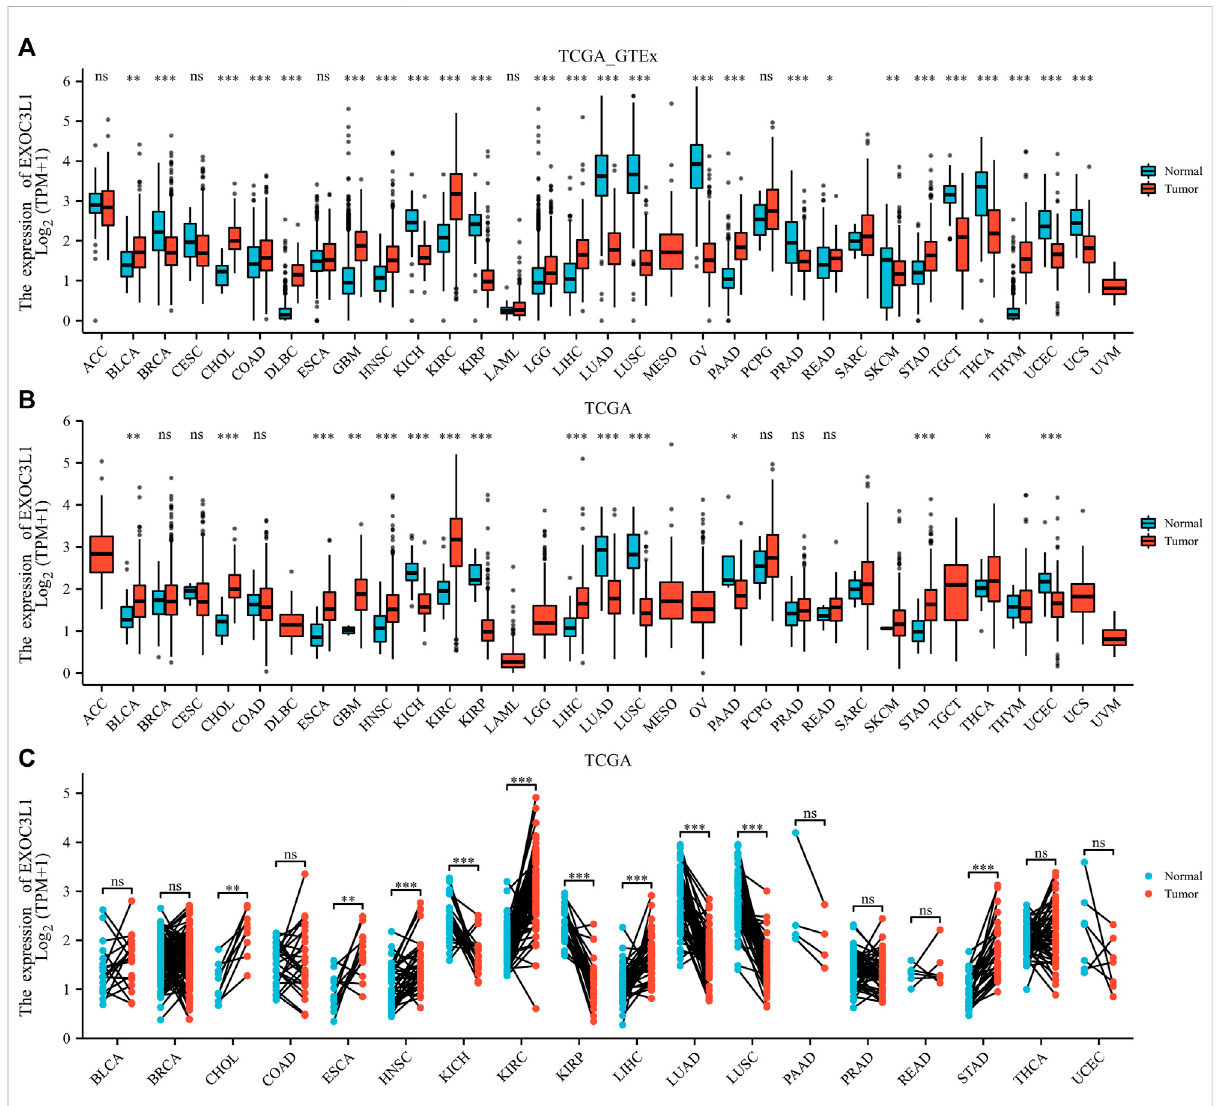
FIGURE 1 The mRNA expression of EXOC3L1 in pan-cancer. (A) The mRNA expression of EXOC3L1 in 33 tumors in TCGA_GTEx samples. (B) The mRNA expression of EXOC3L1 in 33 tumors in TCGA database. (C) Expression of EXOC3L1 in paired samples of 18 tumors in TCGA database. ACC, adrenocortical carcinoma; BLCA, bladder urothelial carcinoma; BRCA, breast invasive carcinoma; CESC, cervical and endocervical cancers; CHOL, cholangiocarcinoma;COAD,colonadenocarcinoma;DLBC,lymphoidneoplasmdiffuselargeB-celllymphoma;ESCA,esophagealcarcinoma; GBM, glioblastoma multiforme; HNSC, head and neck squamous cell carcinoma; KICH, kidney chromophobe; KIRC, kidney renal clear cell carcinoma; KIRP, kidney renal papillary cell carcinoma; LAML, acute myeloid leukemia; LGG, brain lower grade glioma; LIHC, liver hepatocellular carcinoma; LUAD, lung adenocarcinoma; LUSC, lung squamous cell carcinoma; MESO, mesothelioma; OV, ovarian serous cystadenocarcinoma; PAAD, pancreatic adenocarcinoma; PCPG, pheochromocytoma and paraganglioma; PRAD, prostate adenocarcinoma; READ, rectum adenocarcinoma; SARC, sarcoma; SKCM, skin cutaneous melanoma; STAD, stomach adenocarcinoma; STES, stomach and esophageal carcinoma; TGCT, testicular germ cell tumors; THCA, thyroid carcinoma; THYM, thymoma; UCEC, uterine corpus endometrial carcinoma; UCS, uterine carcinosarcoma; UVM, uveal melanoma. (ns, p > 0.05; * p < 0.05; ** p < 0.01; *** p <